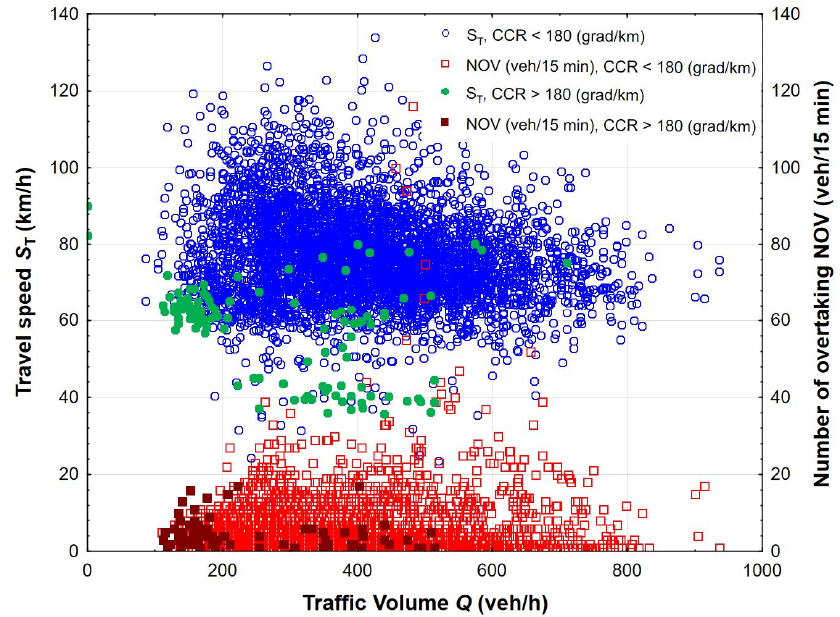
Figure 4. Interaction between travel speed, the number of overtakes and traffic volume throughout a road’s cross-section, with the traffic density below 30 veh/km. Curvature change rate CCR divided into two groups–below and above 180 grad/km. The sample size is 12,565 cases. With the traffic volume in a road’s cross-section exceeding 800 veh/h, the number